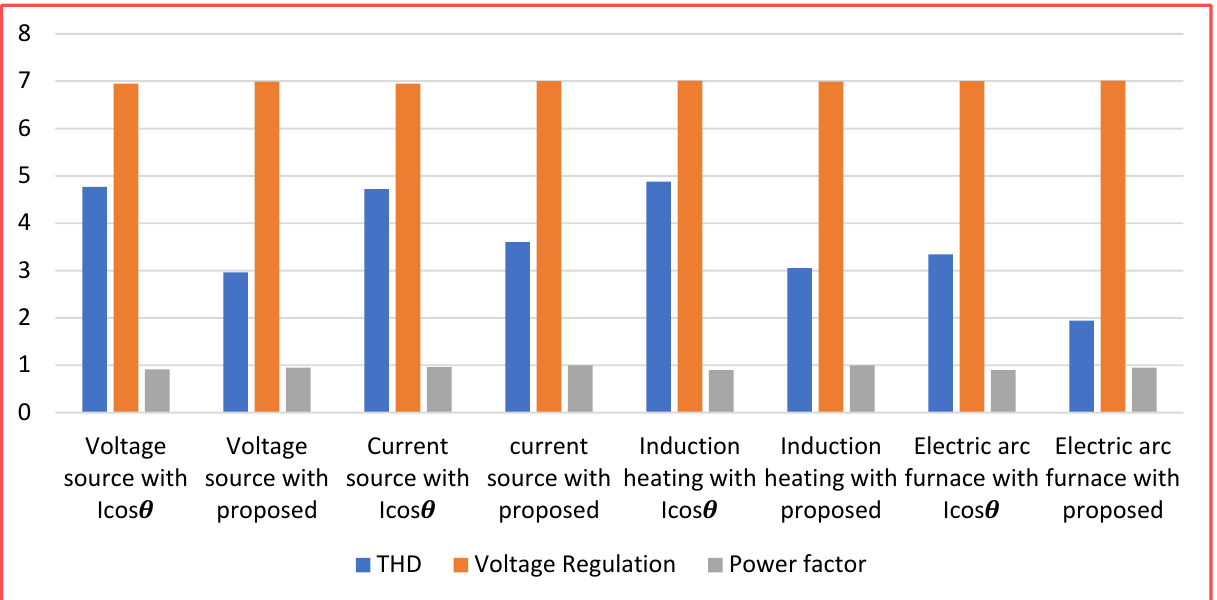
Figure 24. Bar representation of comparative analysis.